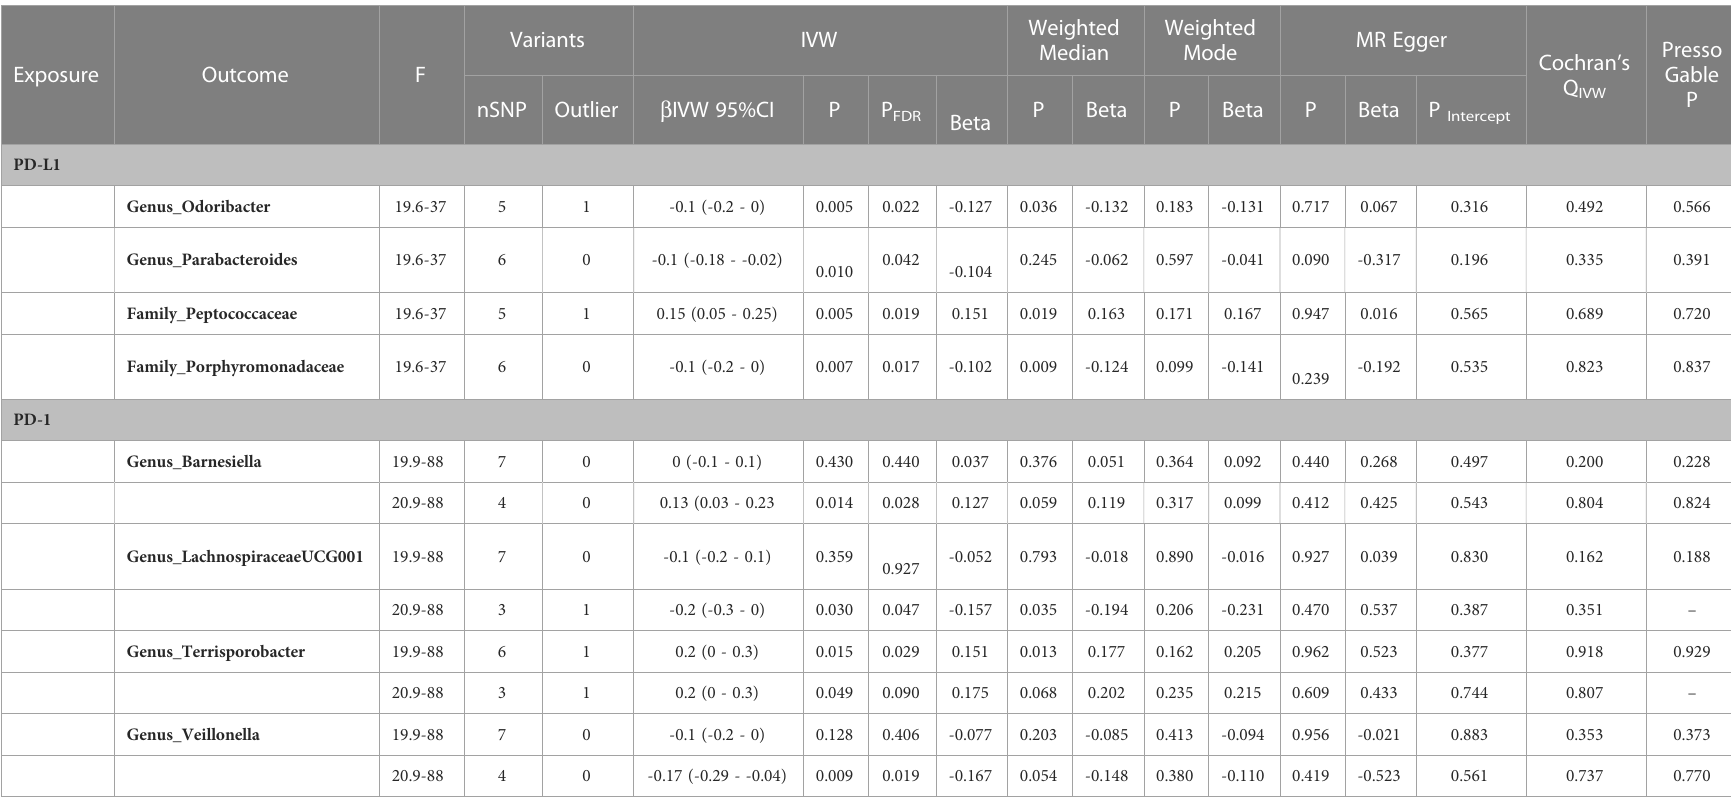
TABLE 1 Signi fi cant microbiota (IVW FDR <0.05) in reverse MR analysis.